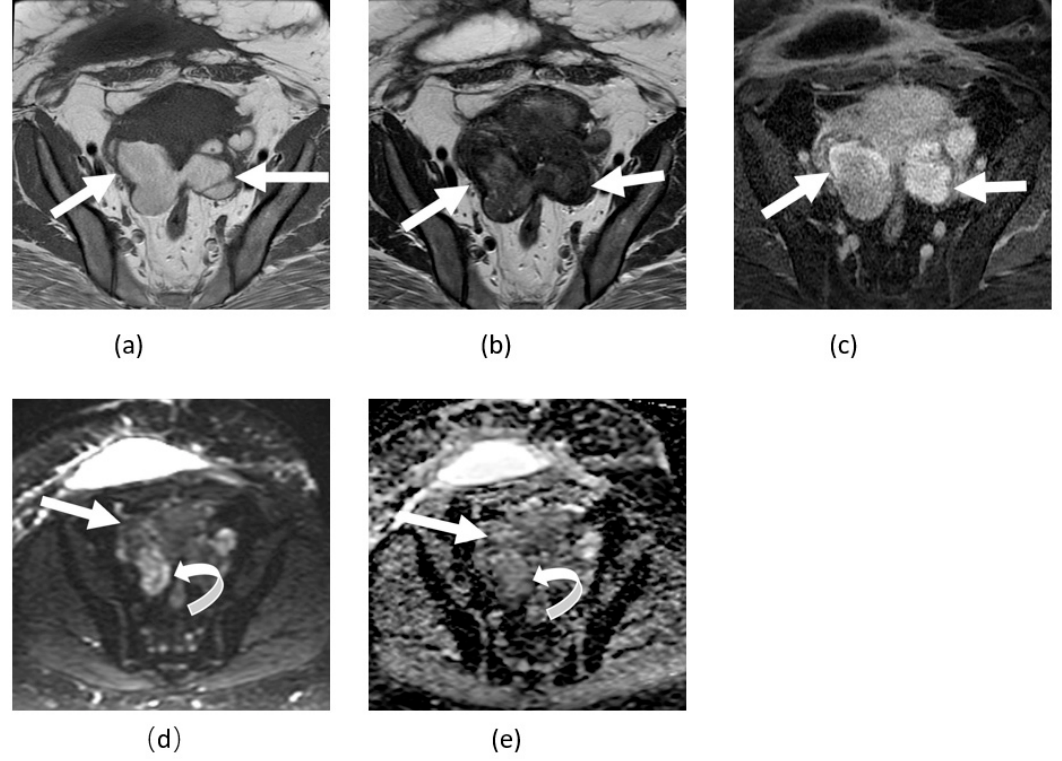
Figure 7. Axial T1 ( a ), T2 ( b ), and T1-weighted unenhanced fat saturation ( c ) images show bilateral enlarged ovarian hemorrhagic cystic lesions consistent with endometriomas (arrows) touching each other in posterior midline of the pouch of Douglas. Axial DWI ( d ) and ADP maps ( e ) nicely depict the variable degree of diffusion restriction of these endometriomas related to different ages of the blood content. Please note right lateral portion of these lesions shows mild diffusion restriction (curved arrows).